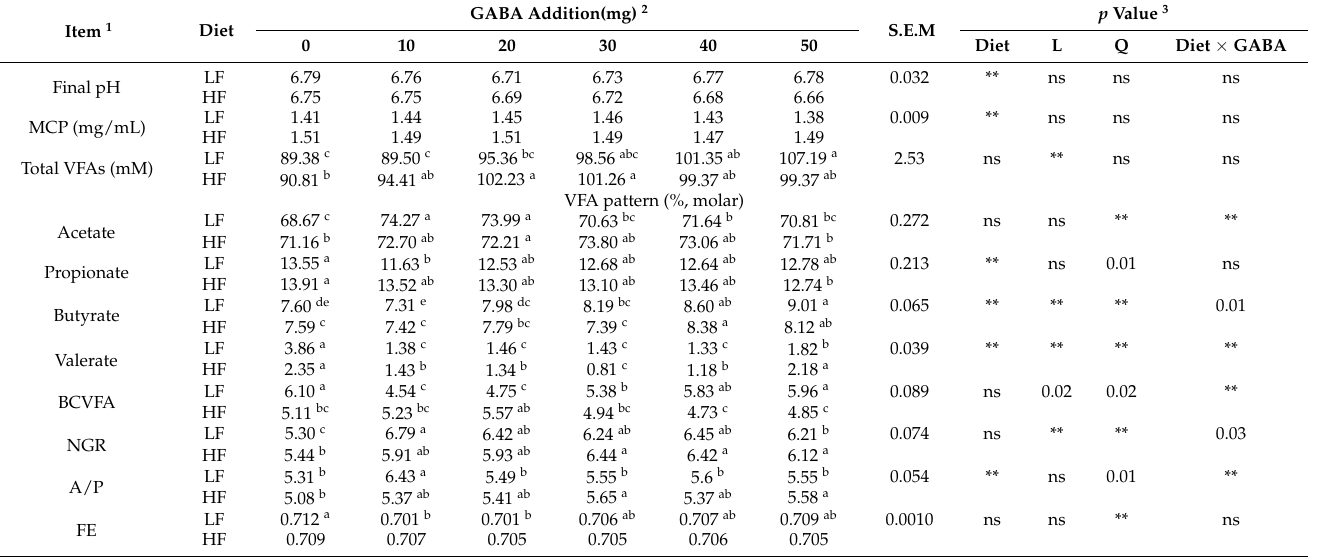
Table 3. Effect of different addition levels of gamma-aminobutyric acid (GABA) in culture fluids on fermentation characteristics of high-fiber (HF) and low-fiber (LF) diets after 72 h incubation together with rumen fluids obtained from dairy